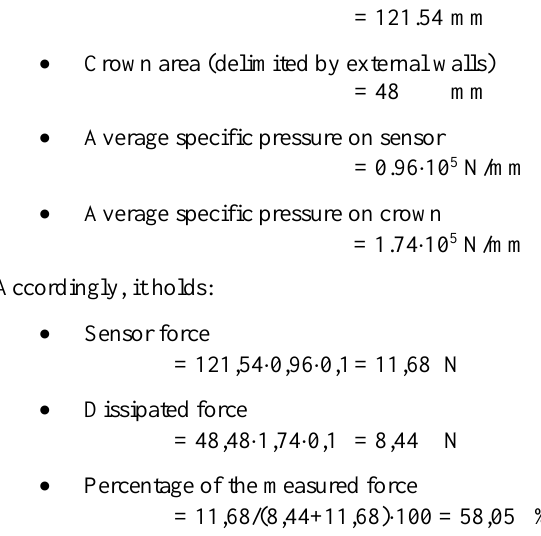
Figure 7. The four different configurations of the tactile bay: from the left to the right, the Deep3R6, Deep3R8, Deep5R6 and Deep5R8 configurations, respectively (details in par. 3.2).